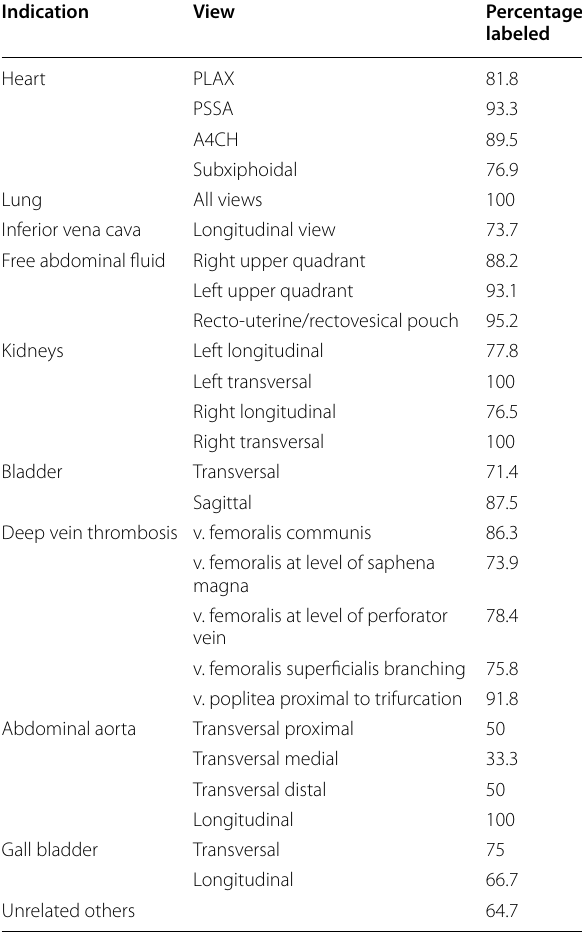
Table 3 Labeling of saved images of specific views